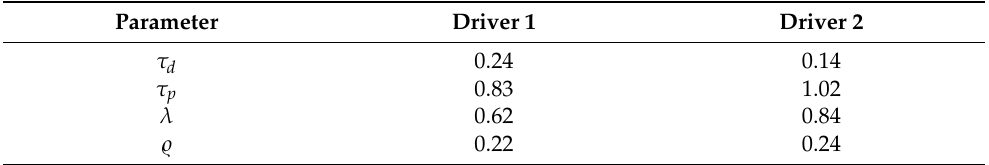
Table 3. Parameters of driver